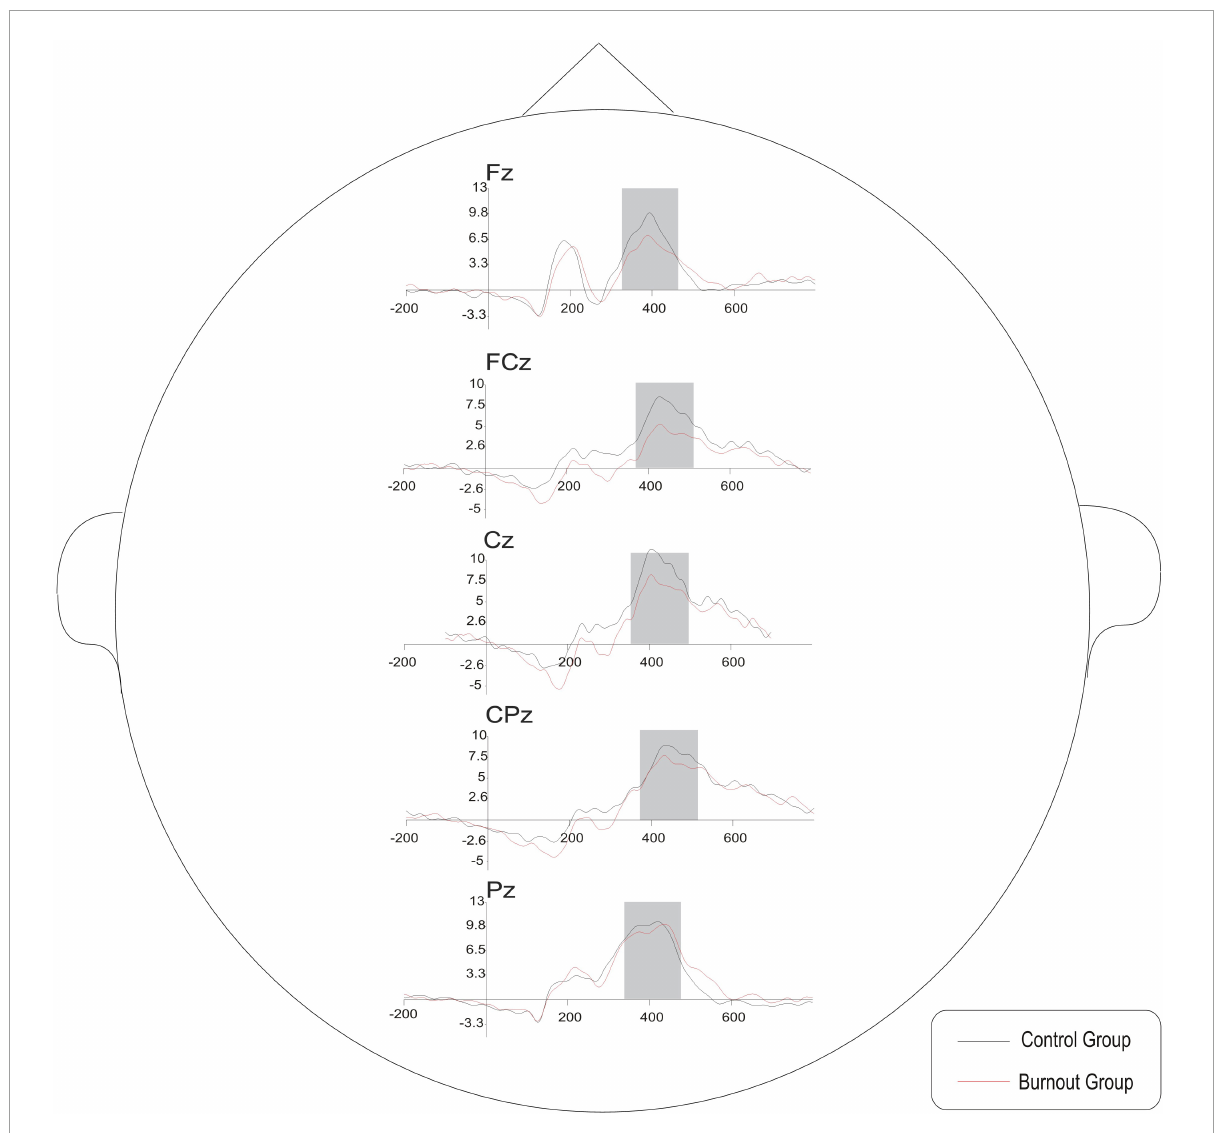
FIGURE3 The average P3a waveforms of the five electrode sites in the burnout group and control group in the oddball